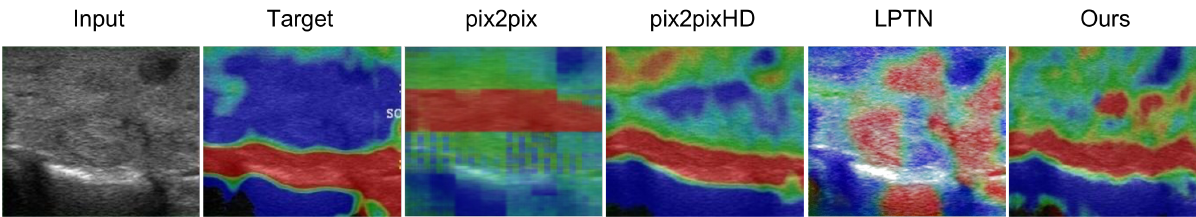
Figure 7. Special example in test images shows that most tissue is hardened, while generated result is not good